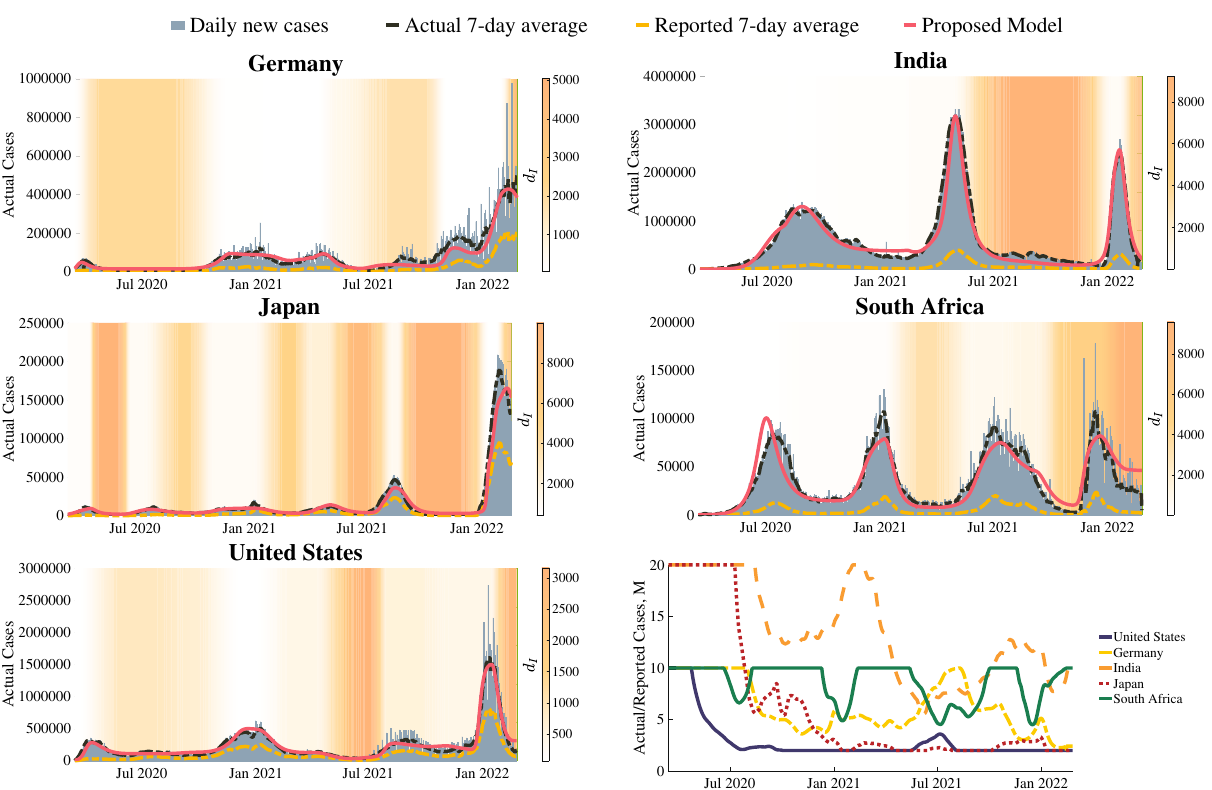
Figure 2. The results of the proposed model fit to Germany, India, Japan, South Africa, and the United States COVID-19 new cases. The model predictions (red, solid) are plotted over the reported 7-day average cases (gold, dashed), estimated actual 7-day average cases (black, dashed), and estimated actual daily cases (gray bars). The level of caution, d I , values from the model fit are plotted as a white-to-orange vertical gradient over time in the plot background, where the color shades of vertical bars correspond to the estimated level of caution. The bottom right plot shows the case underreporting factor, M, for each of the five countries over the course of the simulation. This factor is multiplied by the reported cases to estimate actual